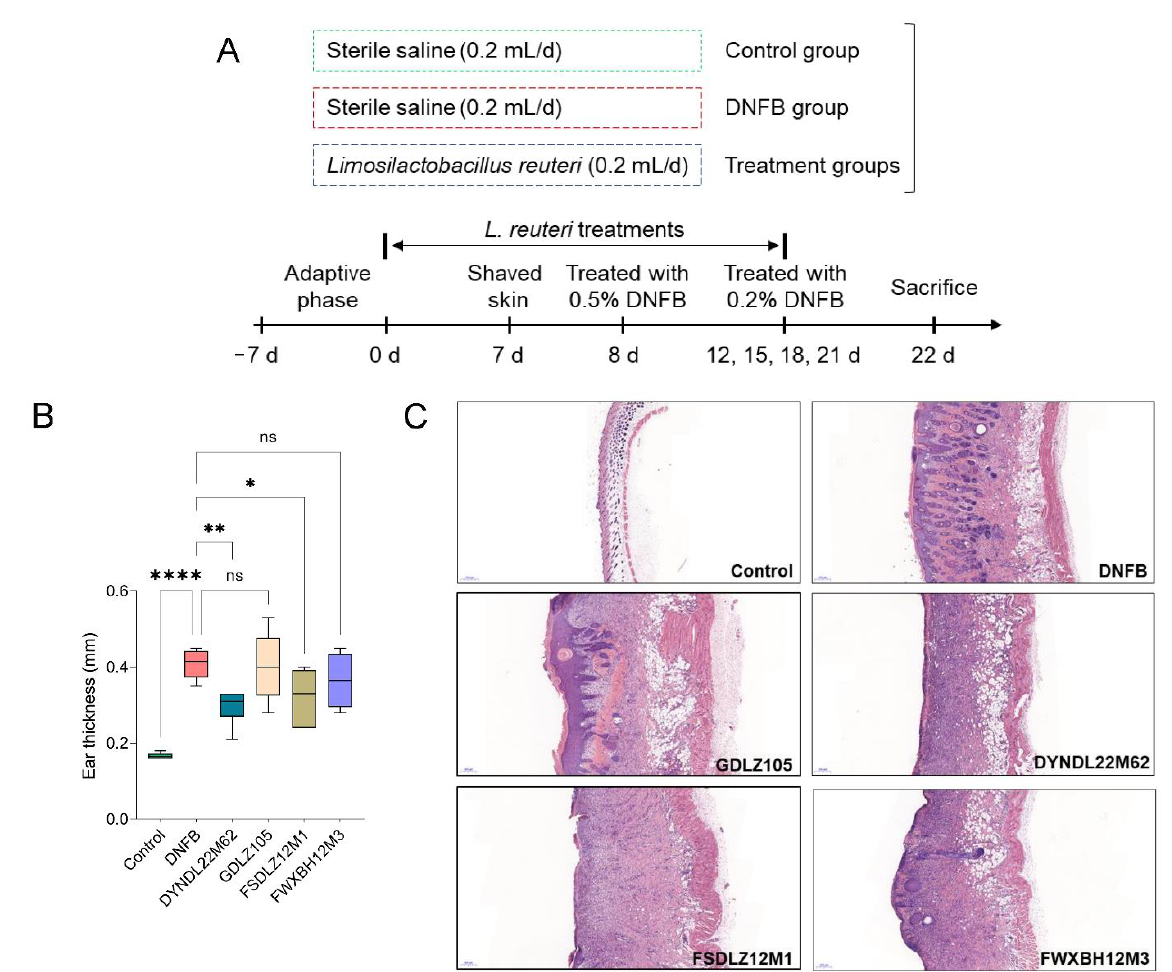
Figure 1. Effects of Limosilactobacillus reuteri on pathological symptoms of AD-like mice. ( A ) Experimental design. ( B ) Effects of L. reuteri strains on ear thickness of AD-like mice. ( C ) H&E staining of skin lesions, scale bar = 200 µ m, original magnification = 400 × . * p < 0.05, ** p < 0.01, **** p < 0.0001 vs. DNFB group.